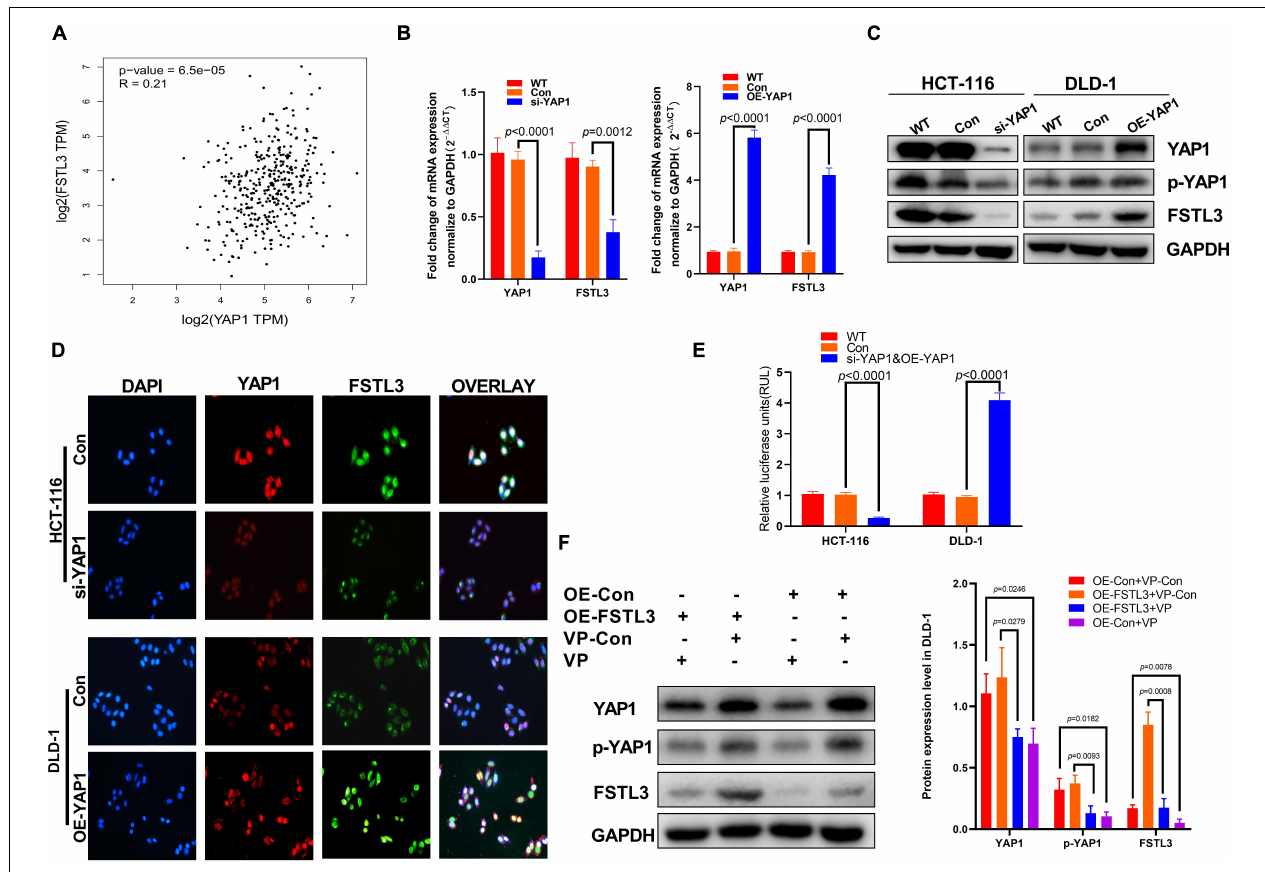
FIGURE 3 | YAP1 modulates the expression of FSTL3 in CRC. (A) Data derived from the GEPIA database showed positive correlation between FSTL3 and YAP1 in CRC tissues. (B) (left) YAP1 knockdown (siRNA) decreased FSTL3 mRNA expression in HCT116 cells, quantified with qRT-PCR; (right) YAP1 mRNA overexpression in DLD-1 cells promotes FSTL3 expression, quantified with qRT-PCR. (C) WB analysis of si-YAP1 and OE-YAP1 in HCT-116 and DLD-1 cells. (D) Immunofluorescence displayed elevated FSTL3 expression following YAP1 overexpression in DLD-1 cells. (E) Luciferase assays for the hFSTL3 gene promoter construct. Reporter activation was analyzed in si-YAP1 and OE-YAP1 CRC cells. (F) WB analysis determined reduced YAP1 phosphorylation and FSTL3 expression levels in Verteporfin (VP)-treated DLD-1